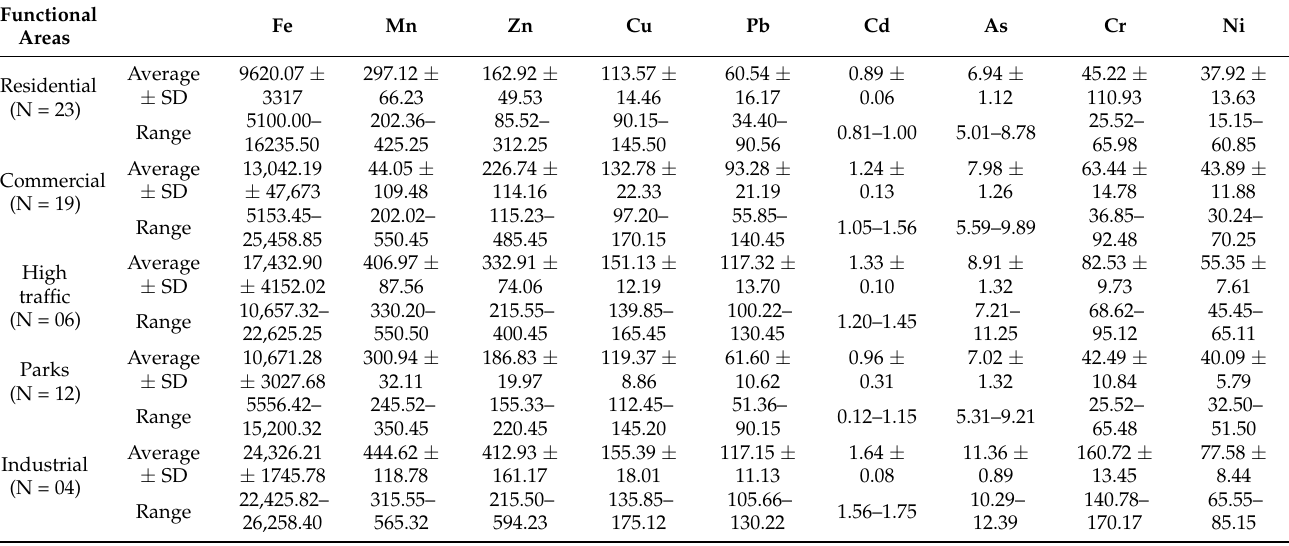
Table 5. Heavy metal concentrations ( µ g · g − 1 ) in road dust samples from urban Lucknow across different functional